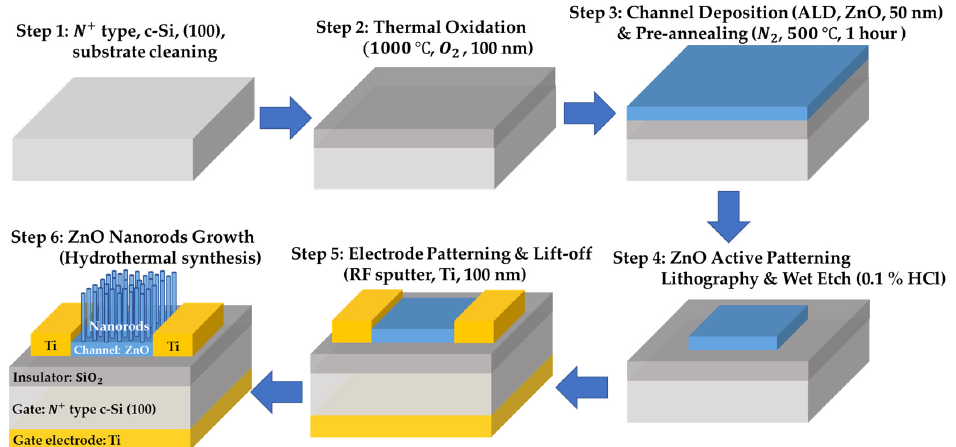
Figure 1. ZnO NRs-based TFT pressure sensor; schematic illustration of the suggested device structure and process flow. The thin film type does not undergo pre-annealing and ZnO NRs growth. The film annealing type omits only the hydrothermal synthesis.